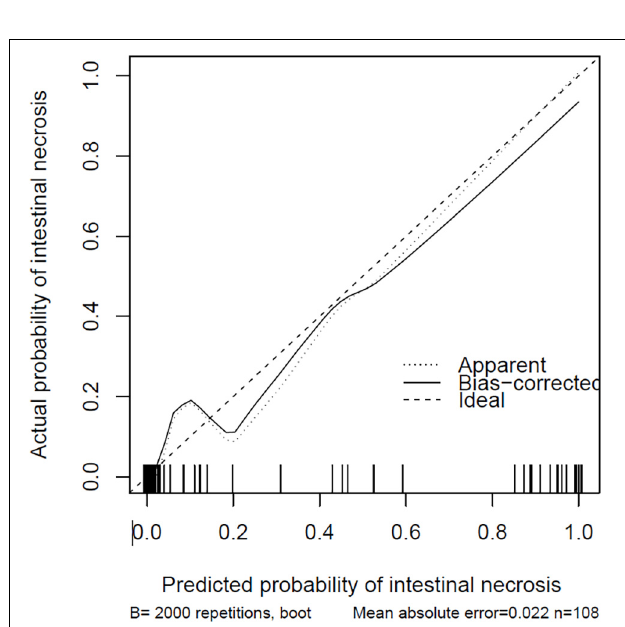
FIGURE 4 | The correction curve for the nomogram